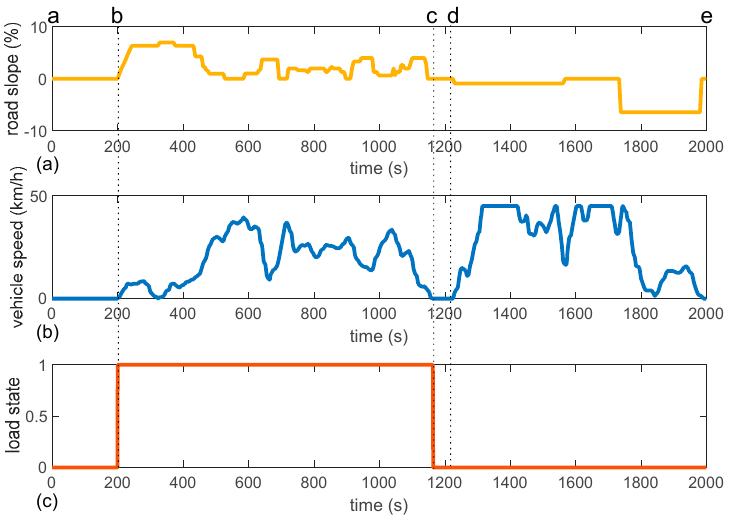
Figure 8. The known working condition information of the heavy-duty mining truck. ( a ) Road slope, ( b ) vehicle speed, and ( c ) load state (1: full-load, 0: no-load). Table 2. Simulation parameters.